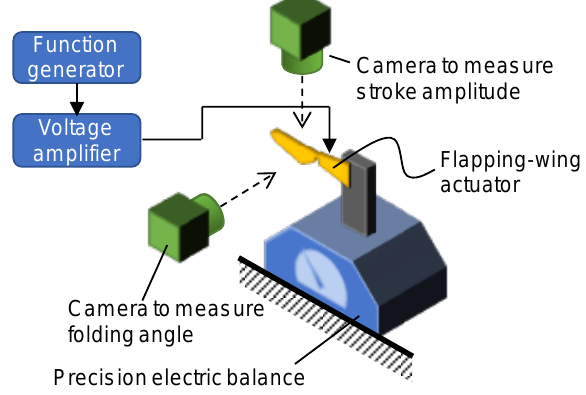
Figure 3. Measurement setup.